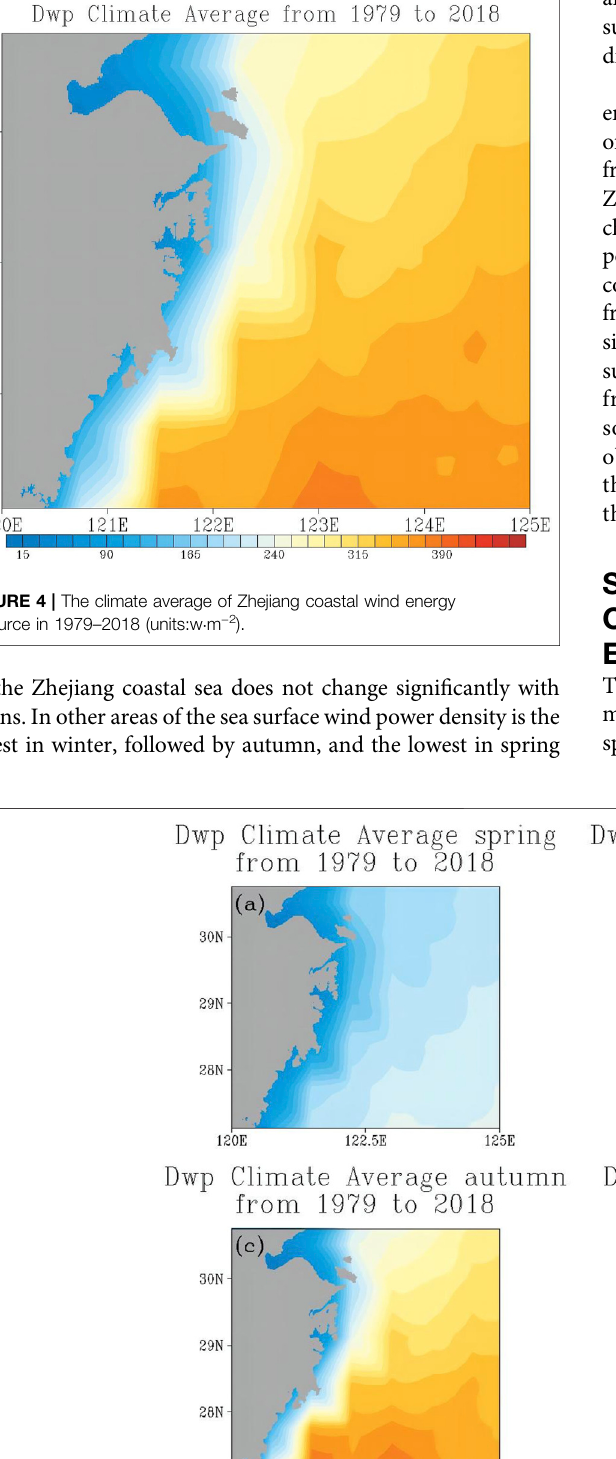
Frontiers in Physics |